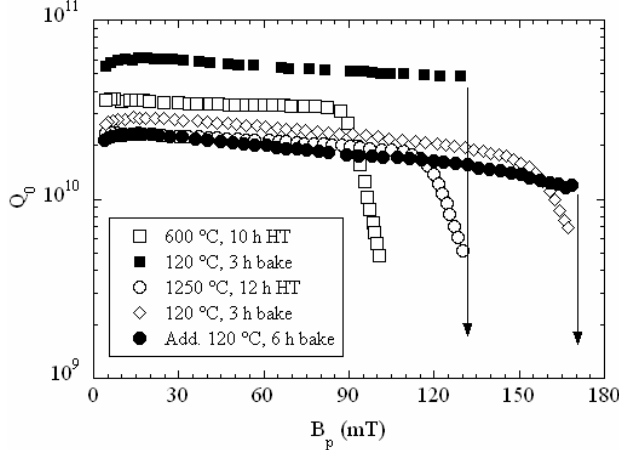
FIG. 15. Q vs B measured at 1.7 K after hydrogen degassing p 0 at 600 (cid:3) C and in situ baking and after postpurification at 1250 (cid:3) C and two consecutive in situ